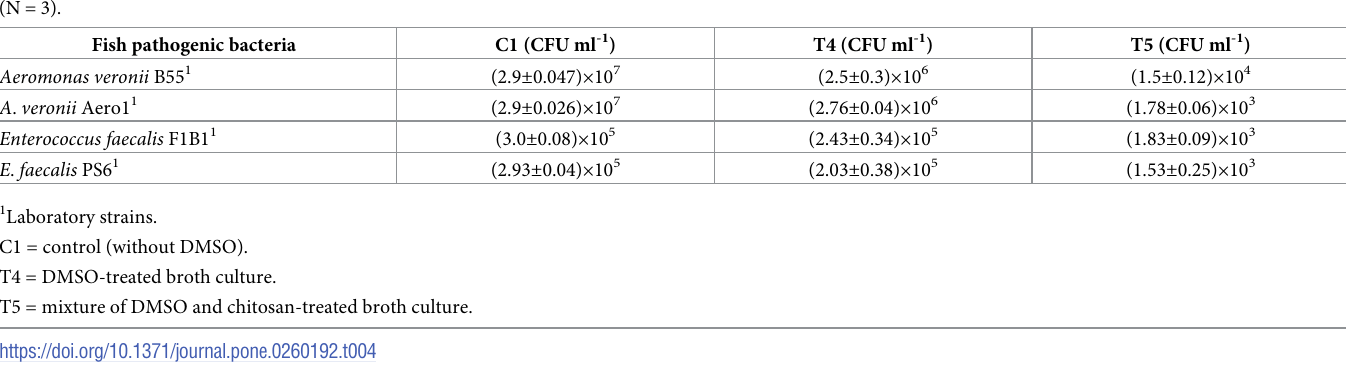
those with the control and other treatments (Fig 3).